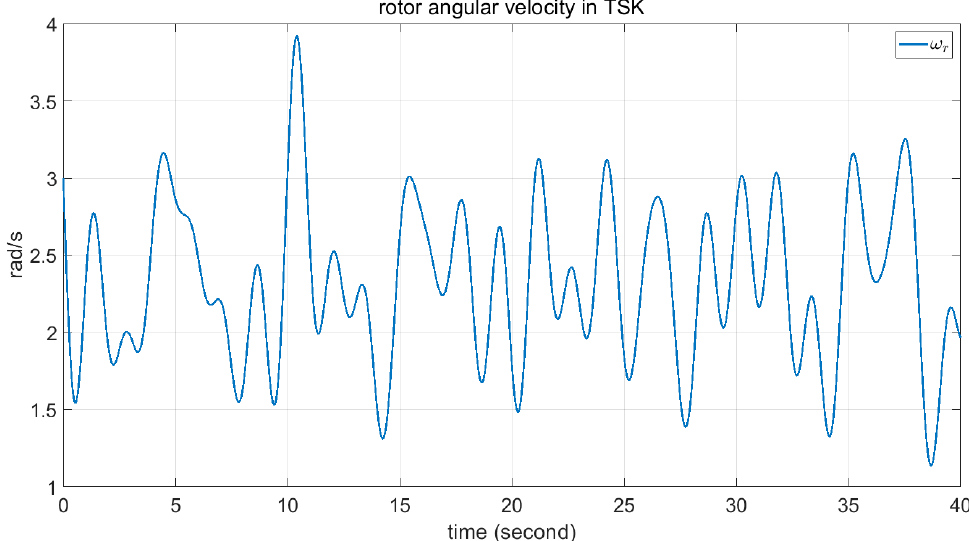
Figure 17. The input control signal of state feedback in fuzzy TSK.